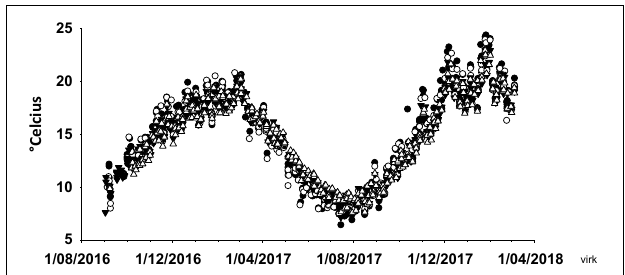
FIGURE 3 | Sea surface temperature in Lyttelton Harbor from August 2016 to April 2018 at four stations (shown with different symbols) within five km from Pile Bay.